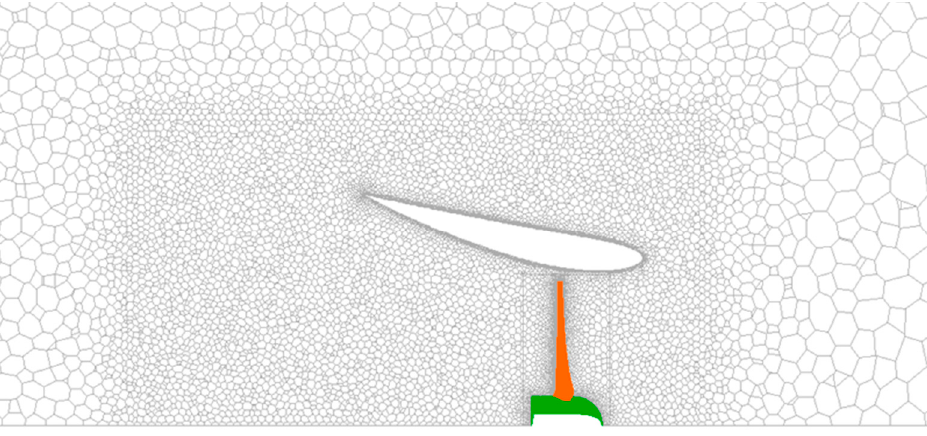
Figure 7. Longitudinal mesh cut.